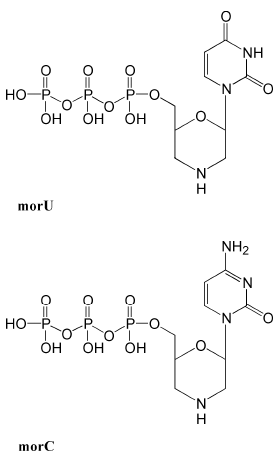
Figure 2. Structures of morpholinonucleoside